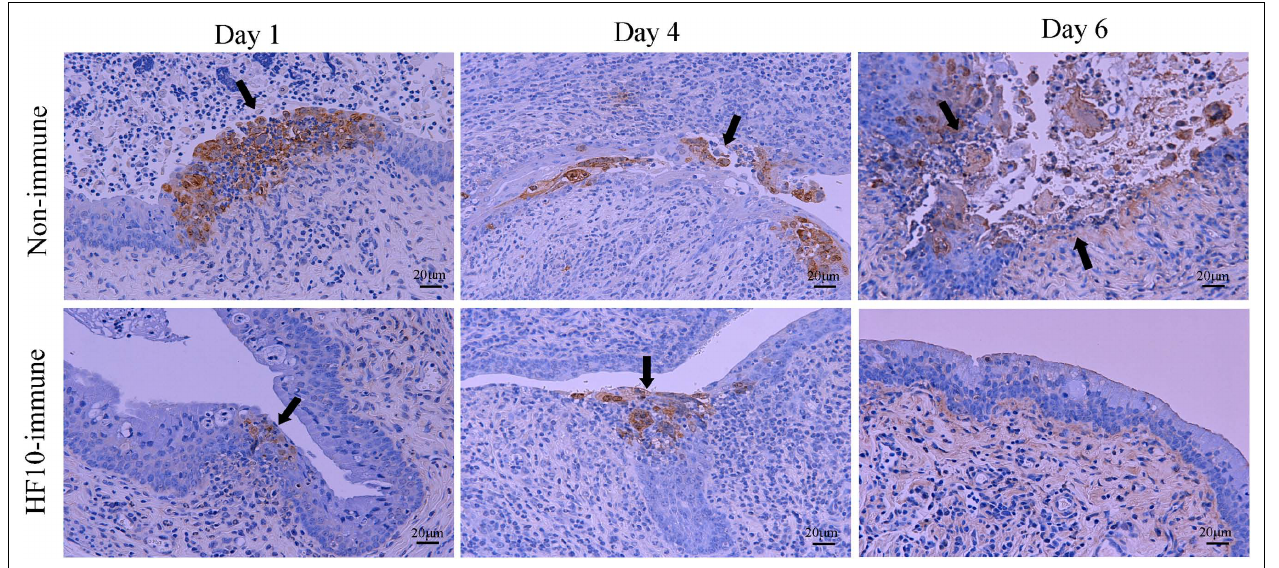
FIGURE 3 | Immunohistochemical evaluation after HSV-2 challenge. After inoculation of wild-type HSV-2 strain 186 into HF10-immunized mice or unimmunized mice vagina; vaginal mucosal lesions were excised at days 1, 4, and 6 after challenge, and HSV-2 antigens were stained. Arrows indicate HSV-2-infected